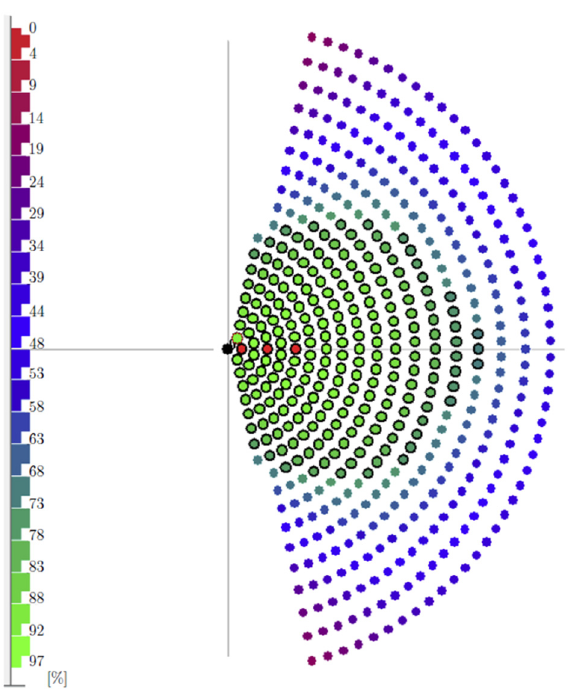
Figure 7. Optical efficiency distribution of the solar field. Figure 7. Optical e ffi ciency distribution of the solar fi eld.